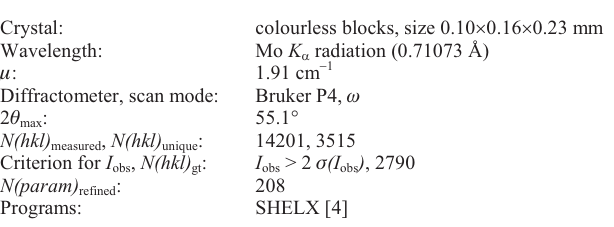
Table 1. Data collection and handling.